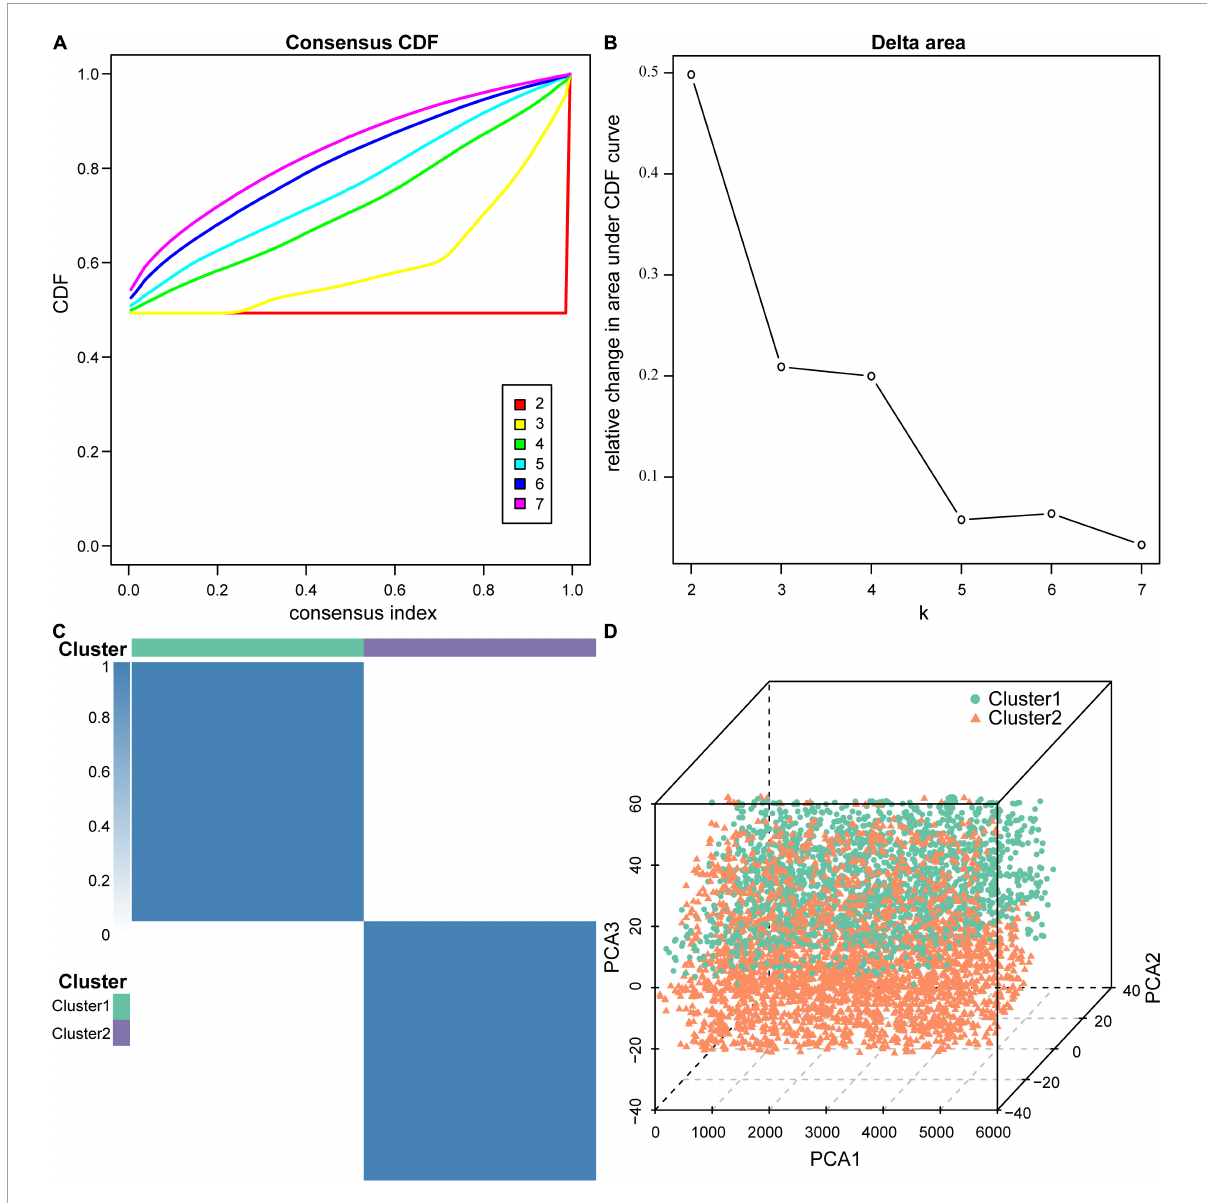
FIGURE7 Molecular subtypes of acute SCI. (A) Cumulative distribution function (CDF) curve of consensus clustering of acute SCI-related genes. The horizontal coordinate indicates the consensus index, the vertical coordinate indicates the CDF index. (B) Relative change in the area under the CDF curve revealing two subtypes with the most stable trend of change. (C) Clustering heatmap of the subtypes of acute SCI-related genes. (D) Principal coordinate analysis plot for acute SCI-related molecular